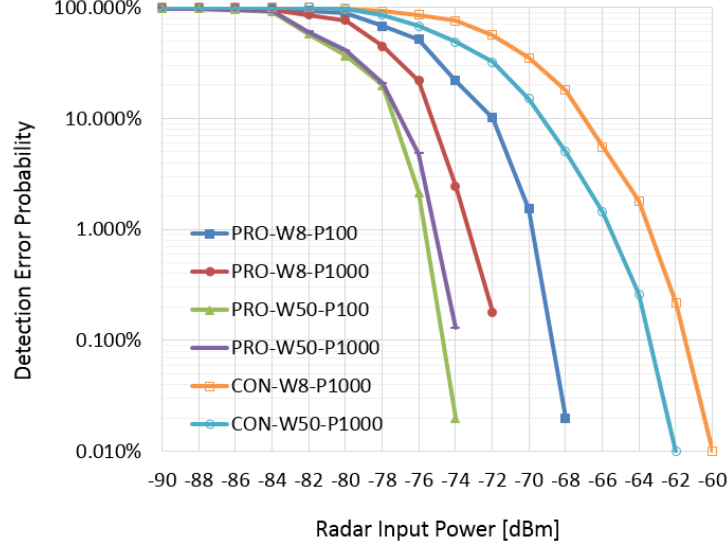
Figure 5. Detection error probability vs. radar input power.